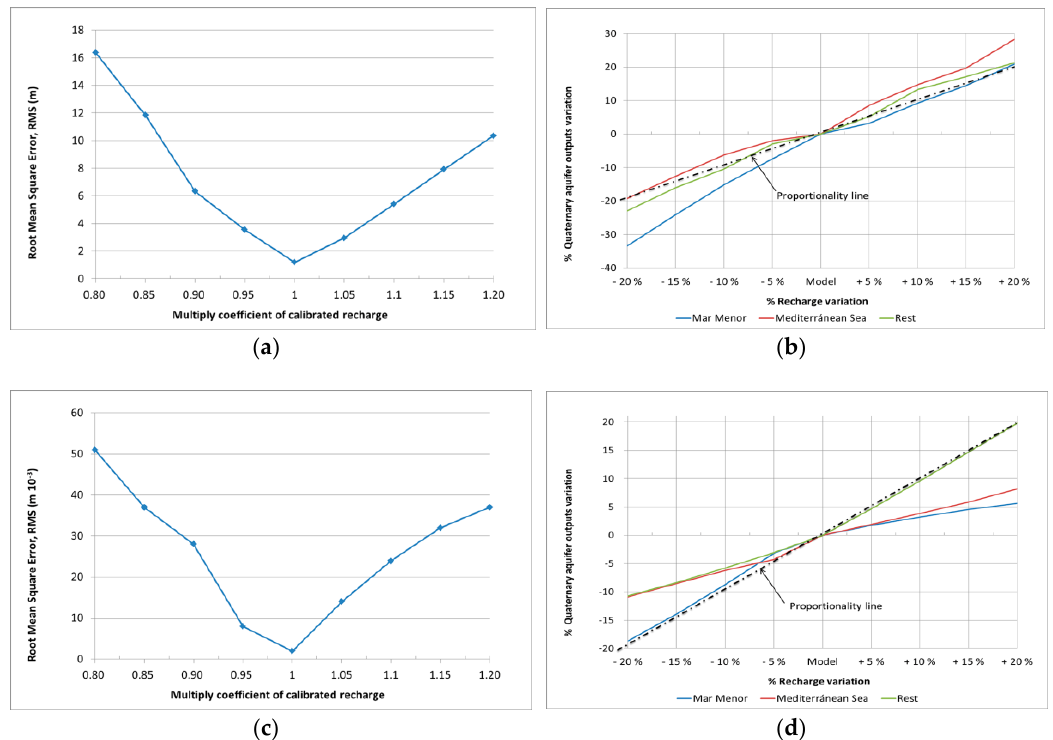
Figure 10. Sensitivity analysis. ( a ) Root mean square error of the steady-state flow model; ( b ) variation of recharge versus variation of output for the Quaternary layer in the steady state (%); ( c ) root mean square error of the flow model in the transient state; ( d ) variation of recharge versus variation of output for the Quaternary layer in the transient state (%).